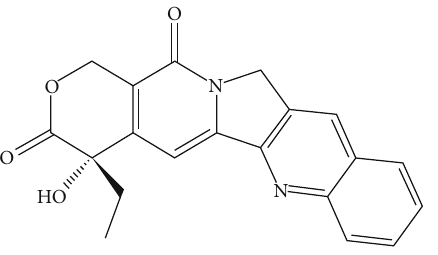
Figure 1: Structure of camptothecin.